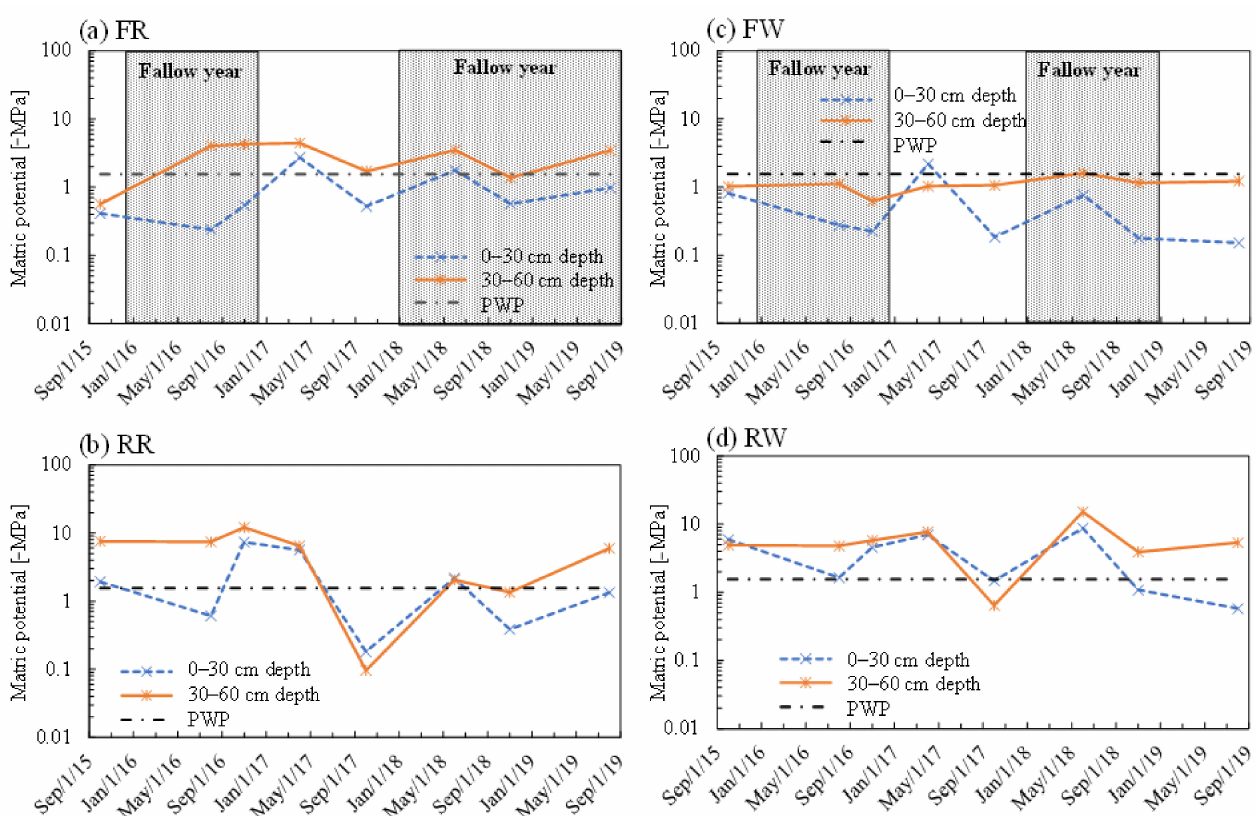
Figure 11. Change in average matric potential in the root zone (0–30 cm depth) and below the root zone (30–60 cm depth) at ( a ) FR, ( b ) RR, ( c ) FW, and ( d ) RW from 2015 to 2019. The dashed lines represent the permanent wilting point (PWP; − 1.55 MPa). FR is the rapeseed field, FW is the wheat field, RR is the rangeland adjacent to FR, and RW is the rangeland adjacent to